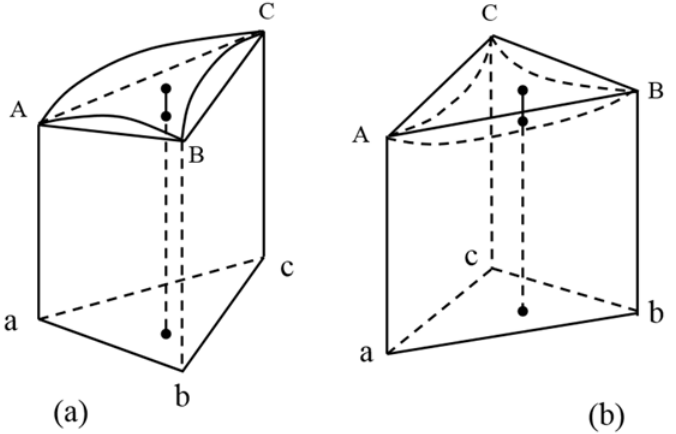
Figure 2. Interpolation using TIN. The interpolation always results in ( a ) an underestimation error in a convex terrain, and ( b ) an overestimation error in a concave